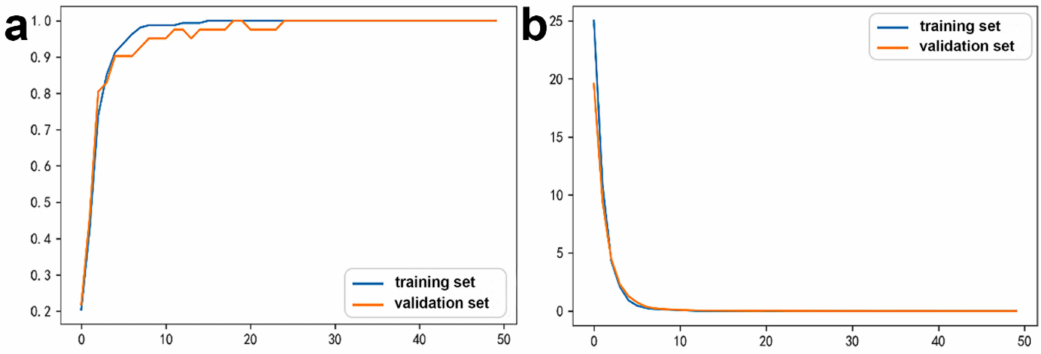
Figure 4. The accuracy and loss of the optimized mRNA DNN model after removing mRNAs with SHAP value = 0. ( a ) Accuracy curve and ( b ) loss curve.